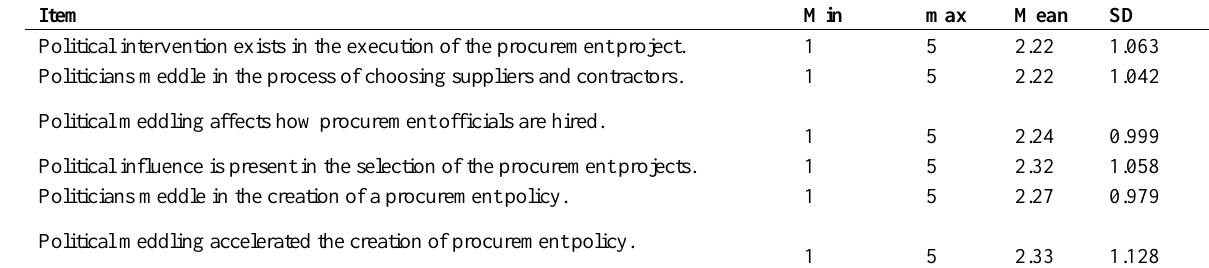
Table 1: Political Interference on Procurement